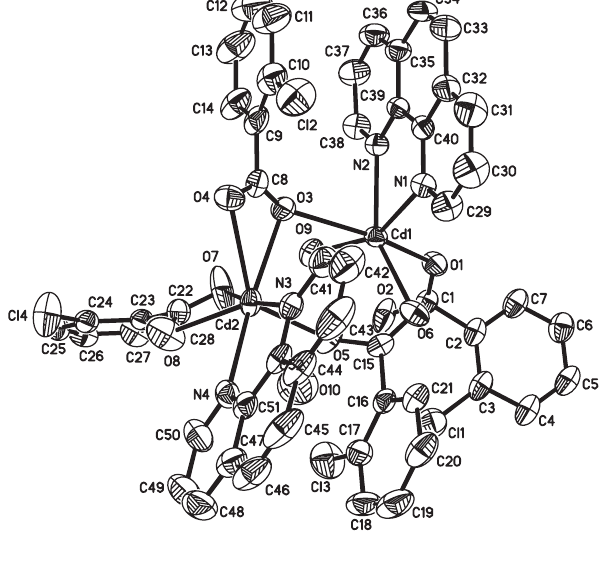
Table 1: Data collection and